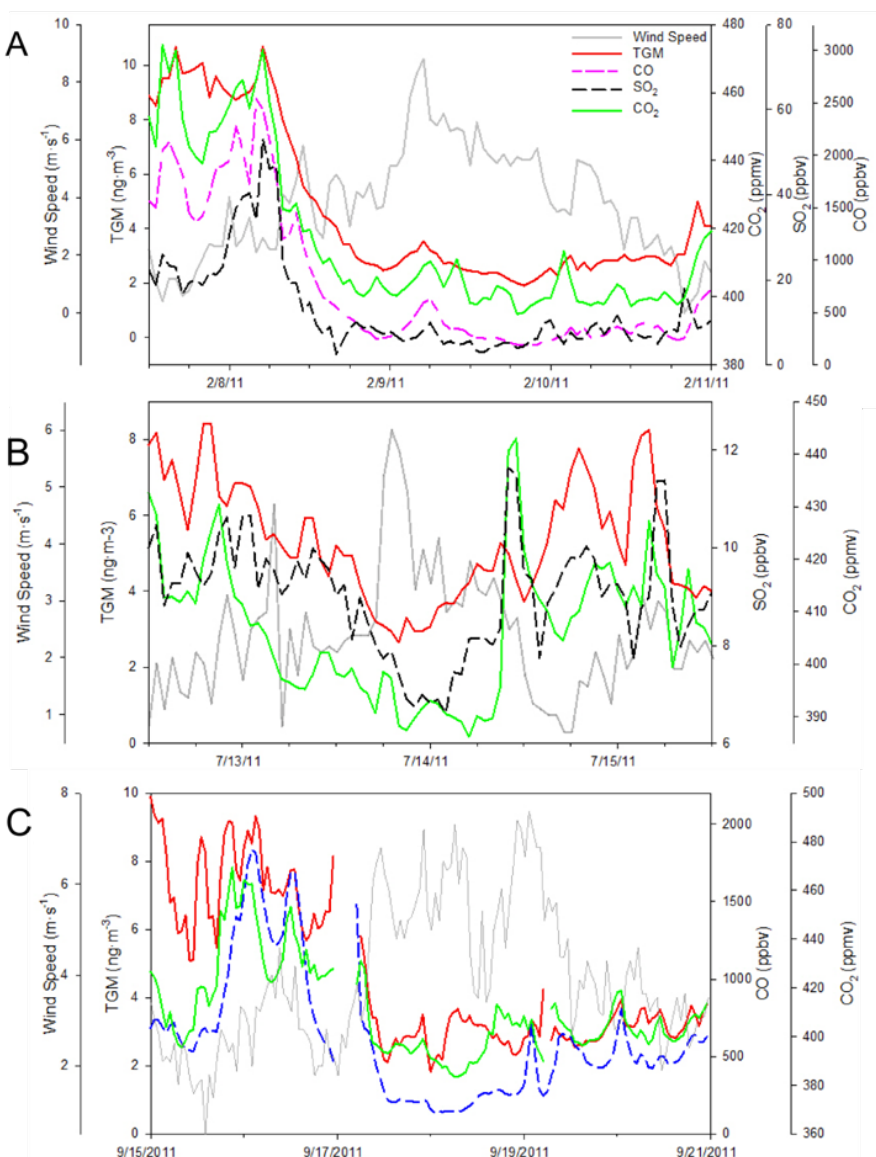
Figure 2. TGM and other urban tracers, CO, CO ( A ) 9 February 2011, ( B ) 13 July 2011 and ( C ) 17 September